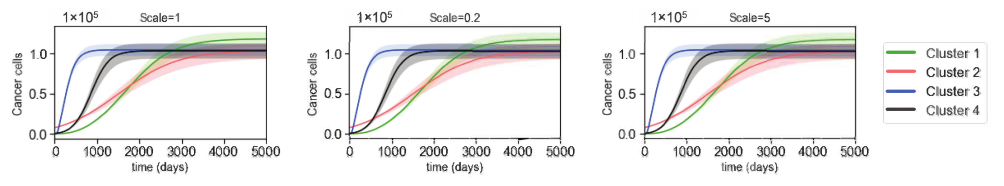
Figure 8. Cancer cell dynamics after scaling α T regions are acquired from 5% perturbation of the most sensitive